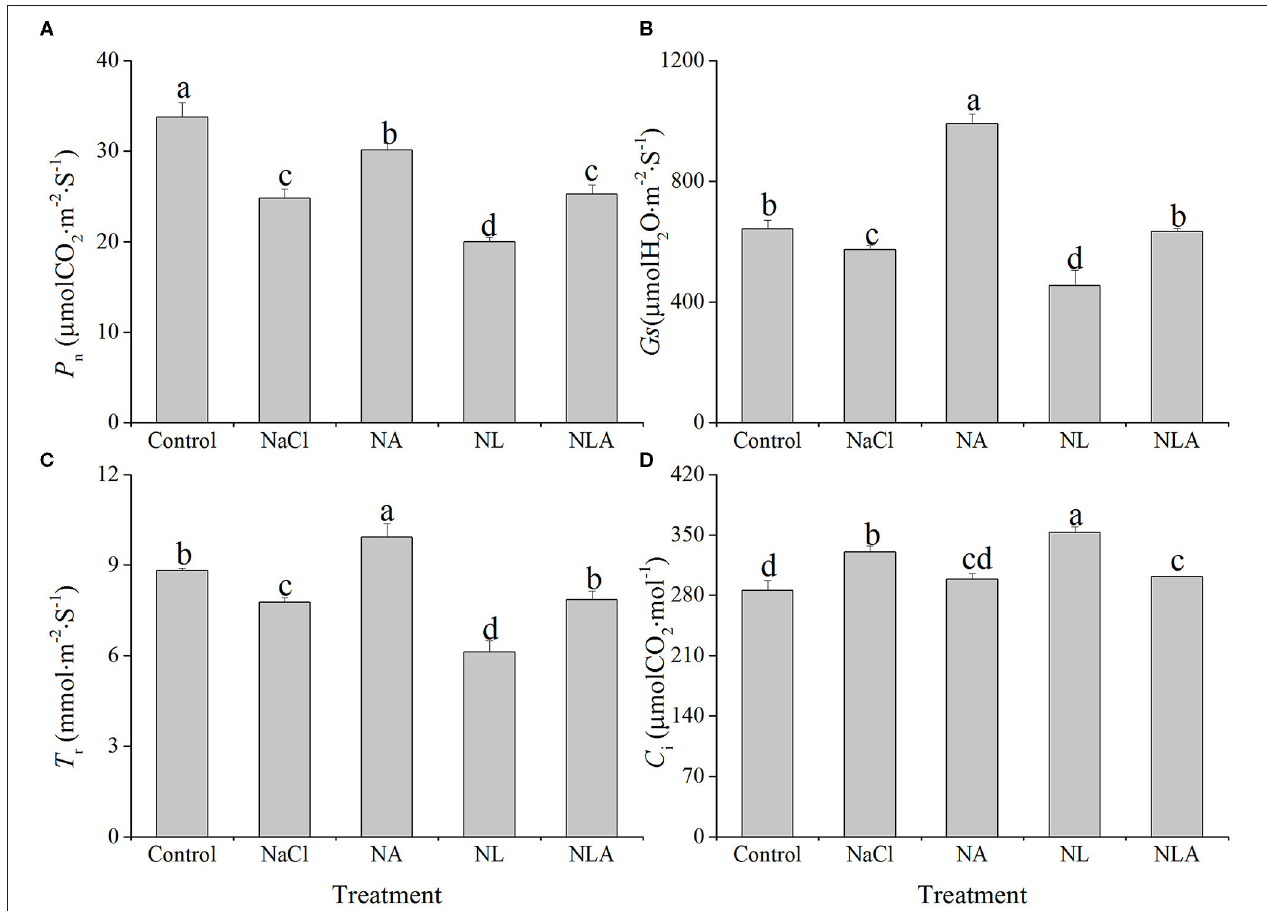
FIGURE 3 | Values of net photosynthetic rate (P n ) (A) , stomatal conductance (G s ) (B) , transpiration rate ( Tr ) (C) , and intercellular CO 2 concentration (C i ) (D) in the leaves of salt-stressed tomato seedlings with or without exogenous ascorbic acid (AsA) and lycorine (LYC) spraying. Values are means ± SD ( n = 3). Different letters (a, b, c, and d) indicate significant difference at P < 0.05 among treatments. Control, no added NaCl, no sprayed AsA and LYC; NaCl, added 100 mmol/L NaCl; NA, added 100 mmol/L NaCl and sprayed 0.5 mmol/L AsA; NL, added 100 mmol/L NaCl and sprayed 0.25 mmol/L LYC; NLA, added 100 mmol/L NaCl and sprayed 0.25 mmol/L LYC and 0.5 mmol/L